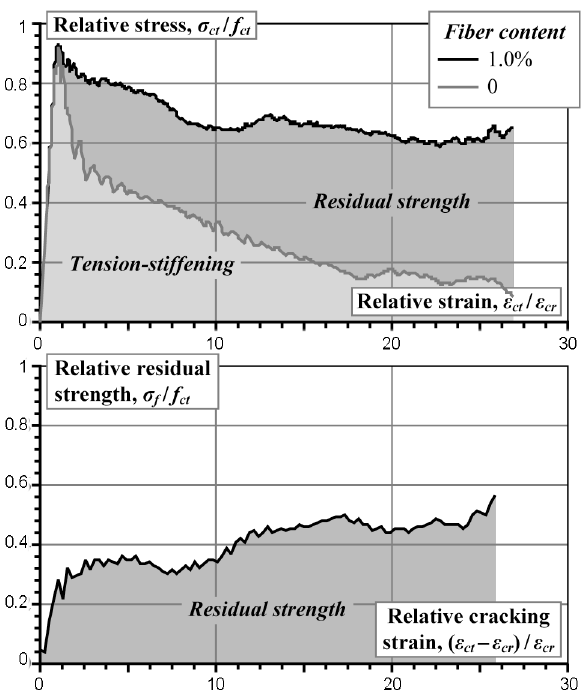
Fig. 1. Average stress-average strain response of tensile steel fibre reinforced concrete obtained from tests of beams with ordinary reinforcement bars (Gribniak et al. 2012)